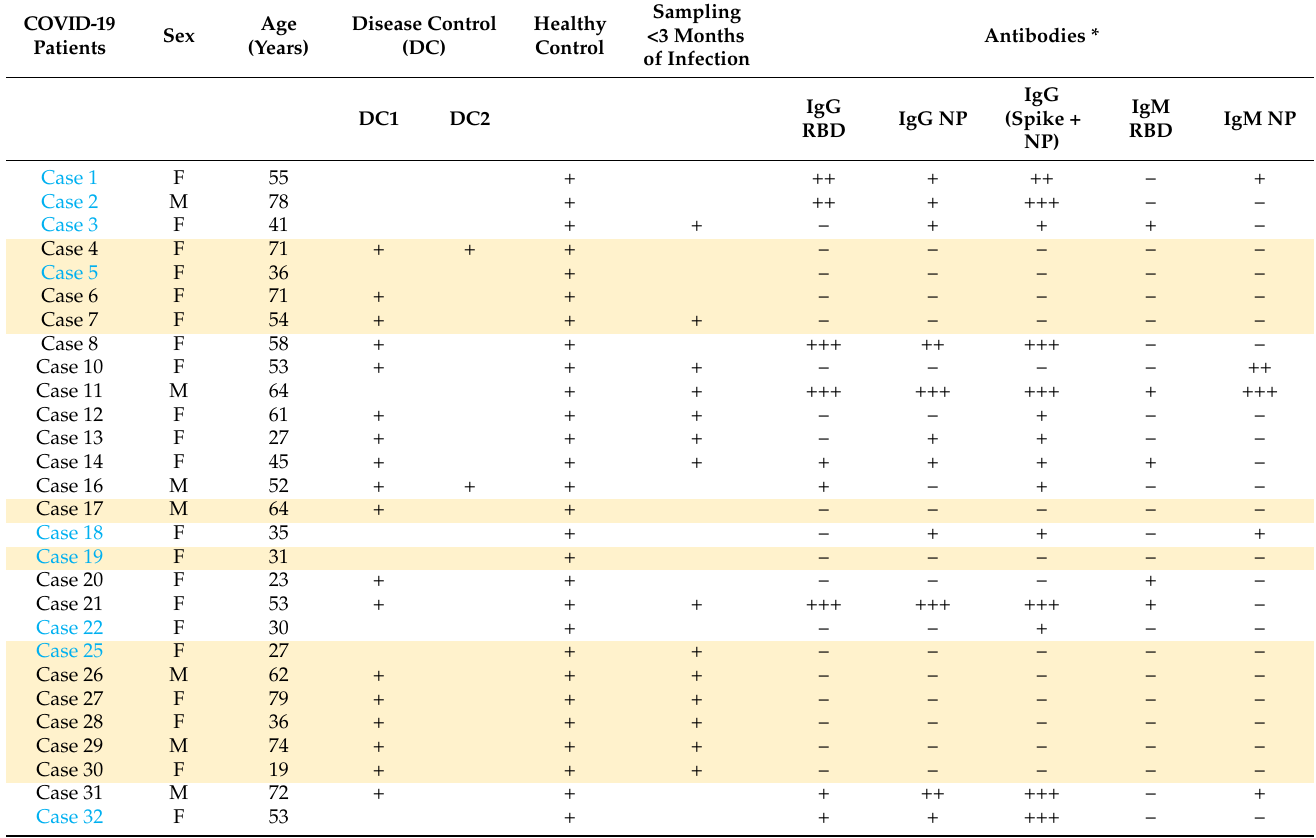
Table 1. Description of the clinical